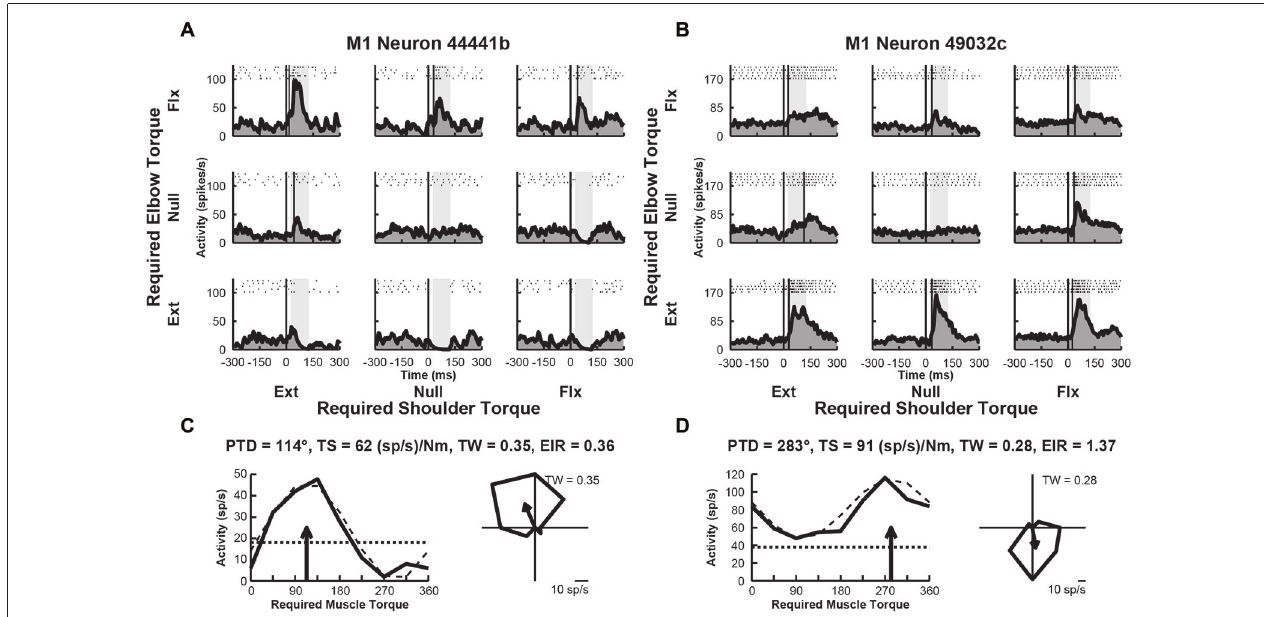
corresponding M1 neurons. Left sub-panels illustrate linear plots of overall activity vs. joint-torque angle. Unloaded baseline activities and cosine fits are shown as dotted and dashed lines, respectively. Right sub-panels show polar plots of the perturbation-related activity (baseline removed) in joint-torque space. PTD, preferred-torque direction; TS, torque-slope; TW, tuning width; EIR, excitation-inhibition